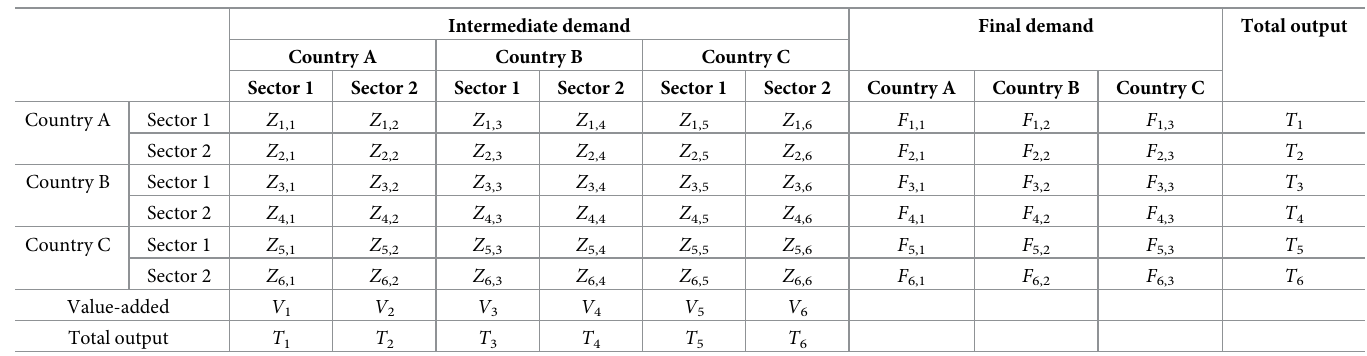
Table 1. World input–output table with two sectors in three